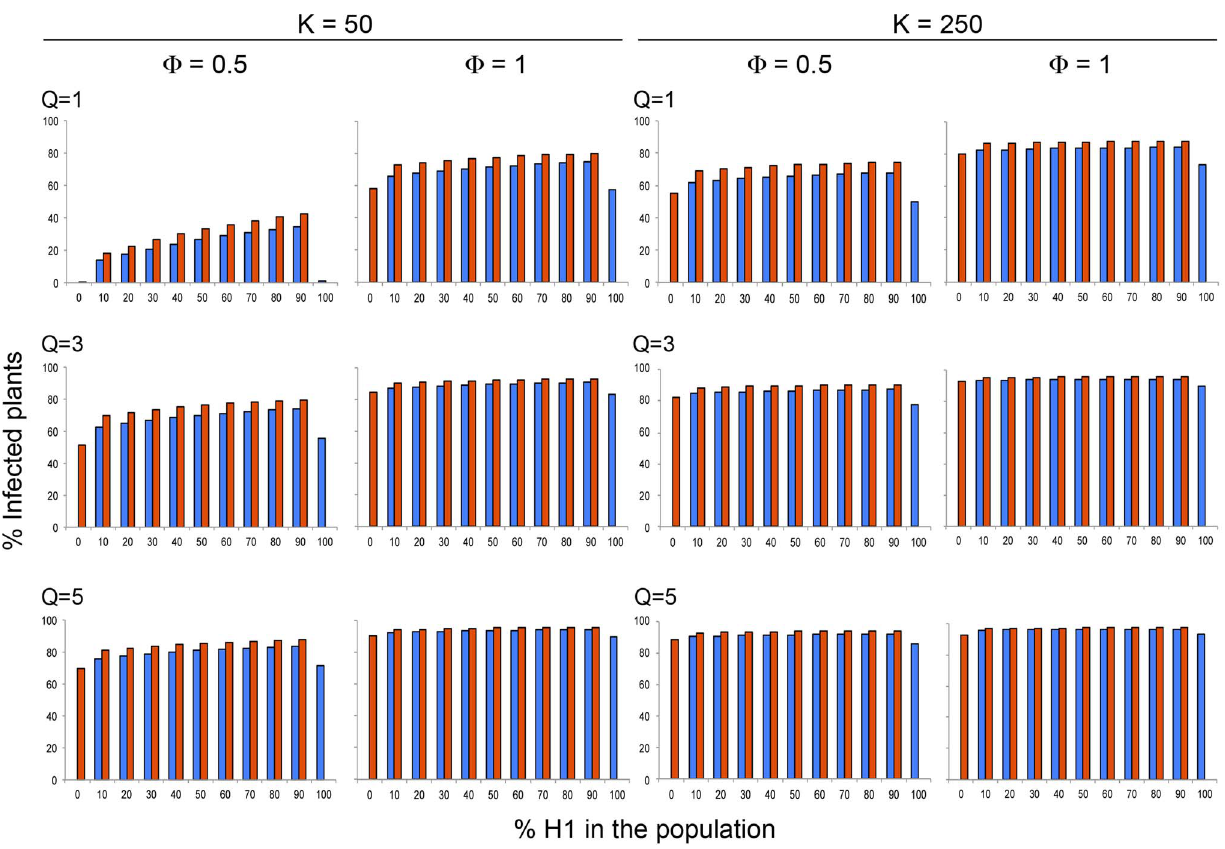
Figure 1. Model simulation values of the variation of CMV incidence in each of the two Arabidopsis genotypes, a short-lived (Host 1 in blue) and a long-lived (Host 2 in red) genotype, within a heterogeneous Arabidopsis population according to the relative frequency of each genotype in the population. Data are presented for two different host plant population densities ( K , plants 6 m 2 2 ), three different aphid densities ( Q , aphids 6 plant 2 1 ) and two different rates of visit per aphids ( W , visits 6 day 2 1 ) at equilibrium.